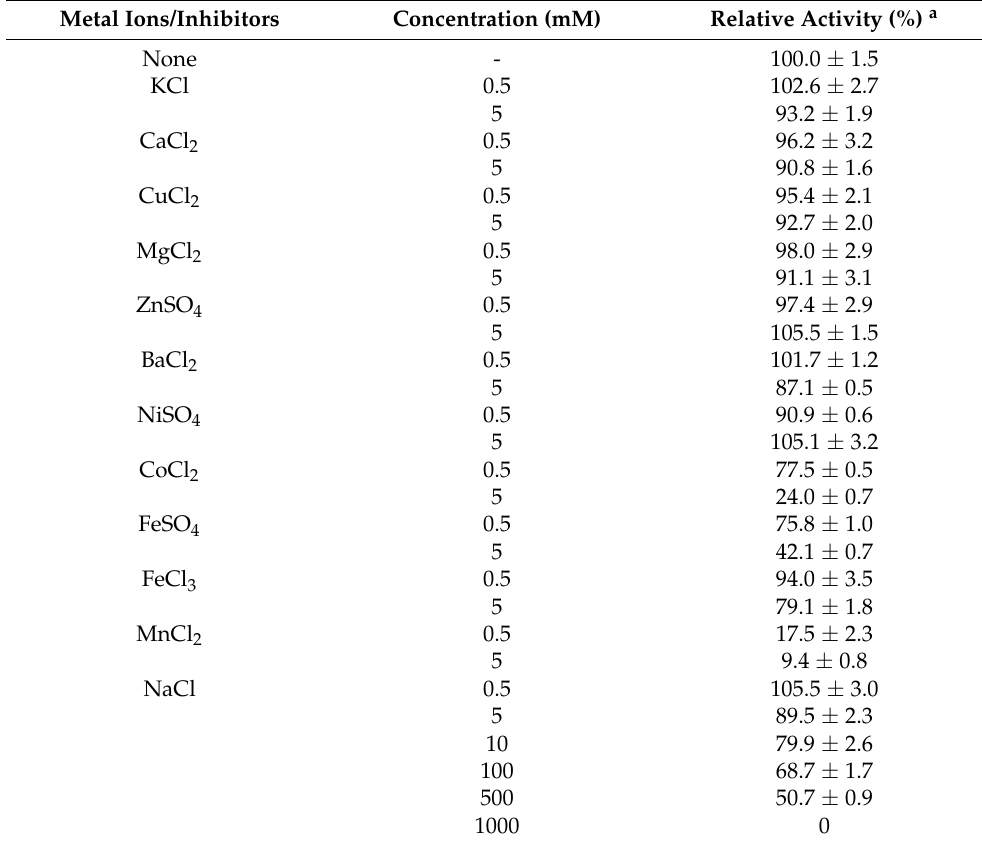
Table 1. Effect of metal ions or inhibitors on the rLAC